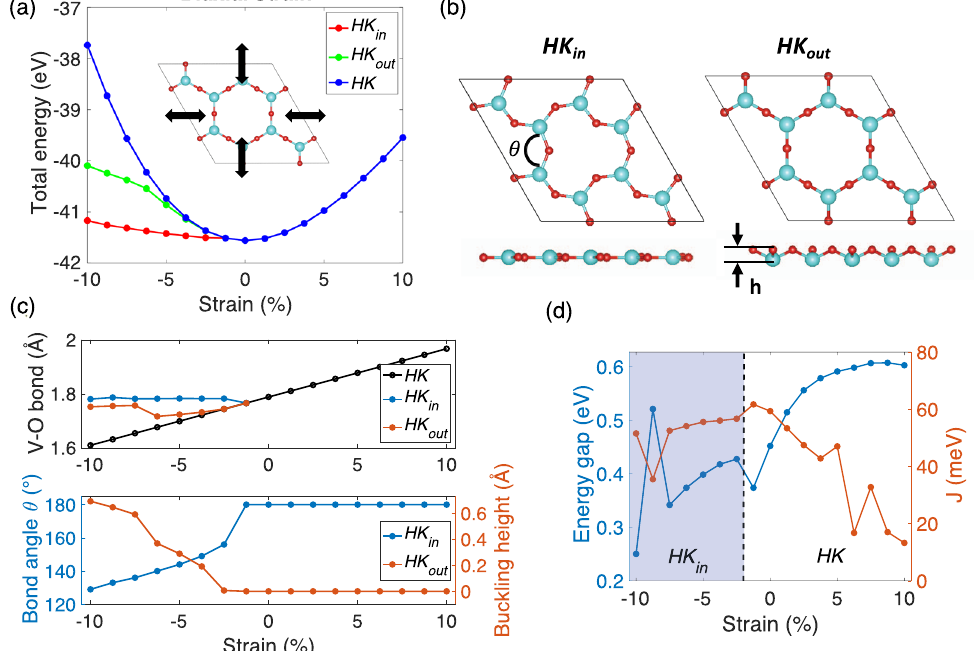
Fig. 4 Biaxial strain study. a The total energy of the system under biaxial strain, taking into account ( b ) the possible structural deformations ( HK in , HK out ) with deformation parameters the bond angle θ and the buckling height h, respectively. c Top: the V – O bond length as a function of strain for all three con fi gurations. Bottom: the bond angle θ and buckling height h in function of the strain for resp. HK in and HK out . d The energy gap and magnetic exchange interaction as a function of